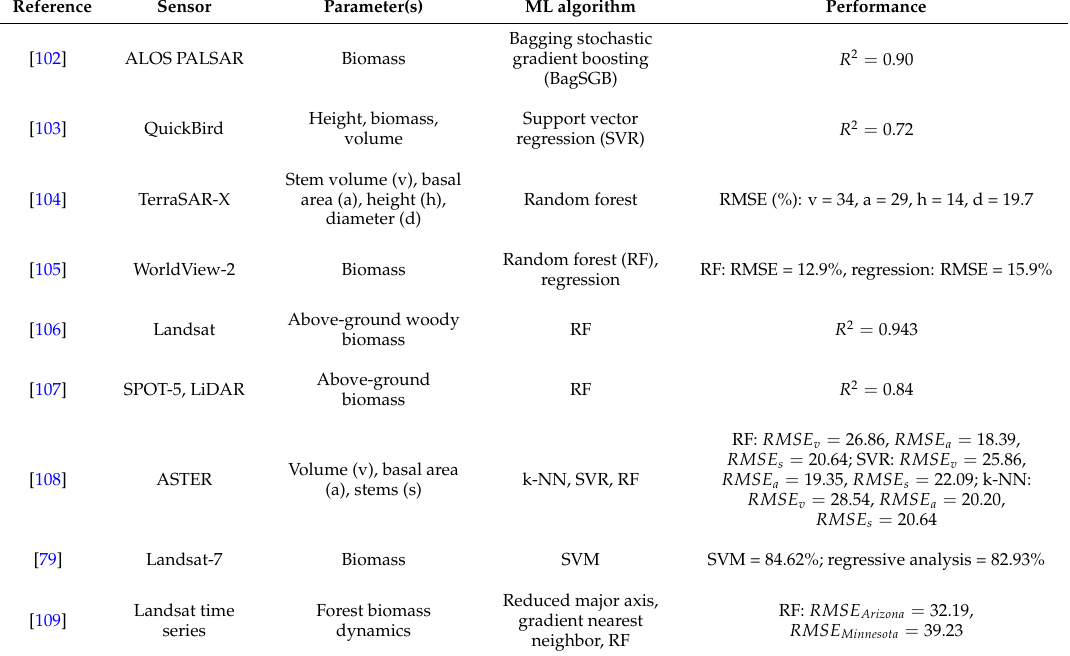
Table 4. Examples from the literature on the application of machine learning methods for forest biomass